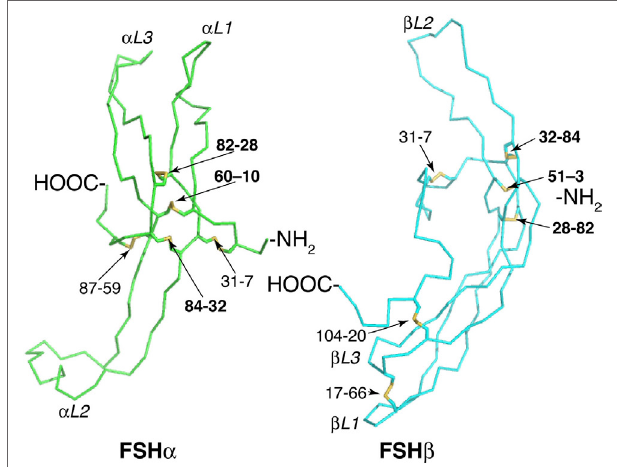
FiGURe 1 | Follicle-stimulating hormone (FSH) subunit peptide moieties. Wire-frame models of FSH subunits extracted from pdb 1FL7 using MacPyMOL v1.8.2.3. FSH α backbone is green and FSH β backbone is cyan. Disulfide bonds are indicated as yellow sticks. Cystine knot loops are designated by subunit ( α or β ) and number (1–3). Pairs of numbers refer to Cys residues involved in a disulfide bond. Bold numbers indicate Cys Knot disulfide